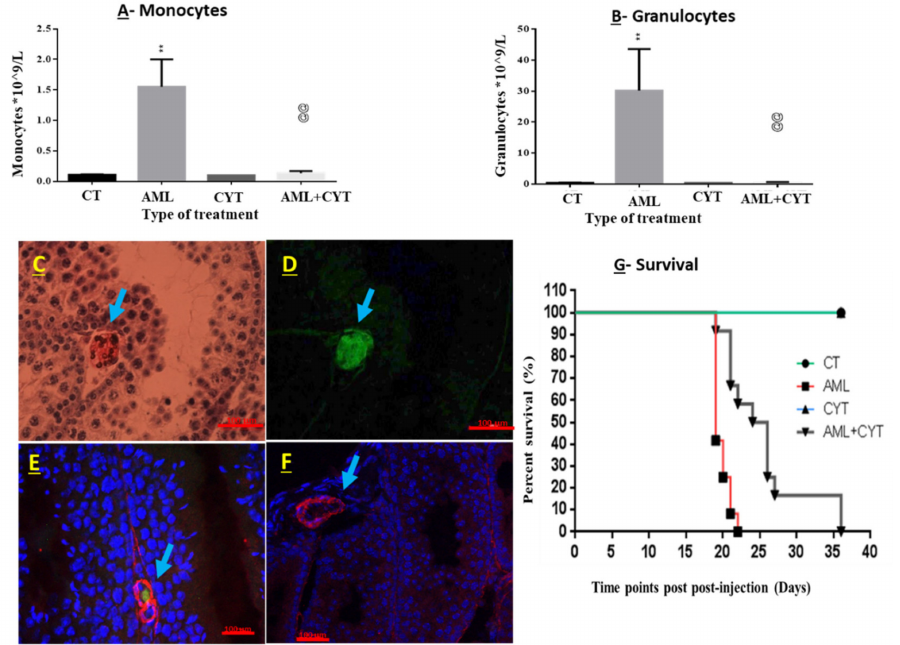
Figure 1. Effect of AML cell line and cytarabine (CYT) on monocytes and granulocytes in the blood vessels, as well as survival of immature treated mice. Two-week-old mice were divided into four groups: untreated (control; CT), injected with AML cells ((i.p.) AML), injected with cytarabine (i.p.) three times and injected with AML cells and cytarabine (AML + CYT). Some of the mice were killed 2 weeks post injection, and the some were kept for survival analysis. Blood was immediately collected from the heart. Monocyte ( A ) and granulocyte ( B ) fractions were then scored. N (number of repeats of all treatments) = 2; n (number of mice examined in all the experiments for each treatment) = 5–9. Fixed testicular tissue was isolated ( C – F ) from GFP-AML-injected mice ( C – E ) and AML-injected mice without GFP; hematoxylin- and eosin-stained sections ( C , D ). H&E-stained sections under green light ( D ). Testicular tissues were immunoassayed with a blood vessel cell marker (a-smooth) (red color) ( E , F ). Arrows indicate the location of blood vessel in the testis. Survival of the mice was followed-up within 35 days ( G ). N (number of repeats of all treatments) = 1–3; n (number of mice examined in all the experiments for each treatment) = 11–12. ** ( p < 0.01) significant relative to control group. @@ ( p < 0.01) significant in relative to AML